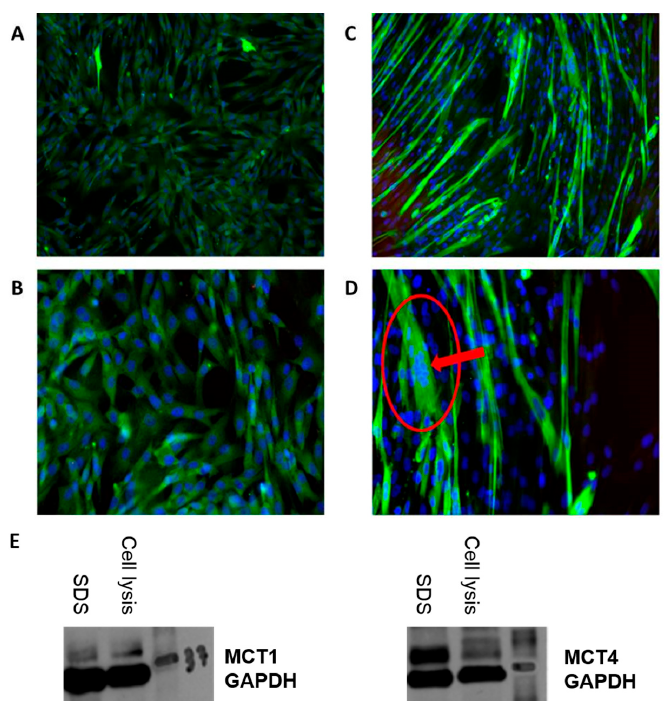
Figure 1. SkMC . Primary human myoblasts from Cell Applications Inc. were proliferated in 35 × 10 mm culture plates with SkMC growth medium for 25–35 days until 80–90% confluency and photographed at ( A ) 10 × and ( B ) 20 × . SkMC in differentiation . Differentiated SkMCs with multinucleated syncytia after exposition for 6 days with the SkMC differentiation medium are photographed at ( C ) 10 × and ( D ) 20 × . ( E ) Expression of MCT1 ( left ) and MCT4 ( right ) proteins in SkMCs was revealed by Western blotting using antibodies against MCT1, MCT4 and GAPDH (the 2 wells illustrated—SDS vs. cell lysis—represent 2 different methods tested for protein